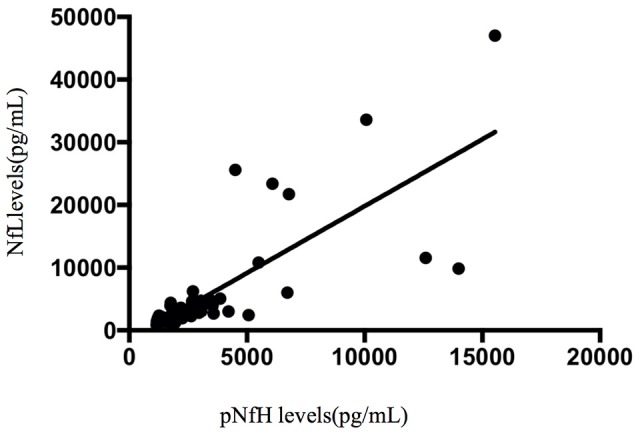
A positive correlation between CSF pNfH and NfL.